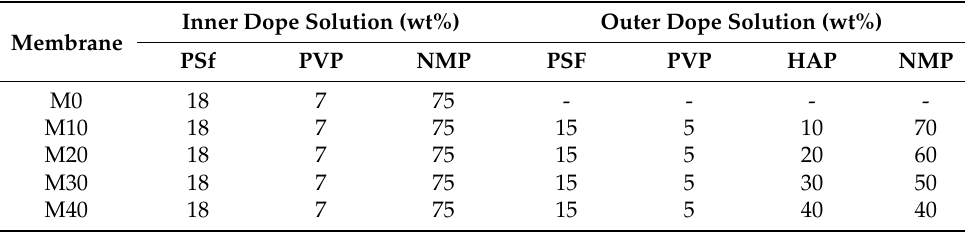
Table 1. Inner and outer dope composition of neat SLHF and DLHF membrane.